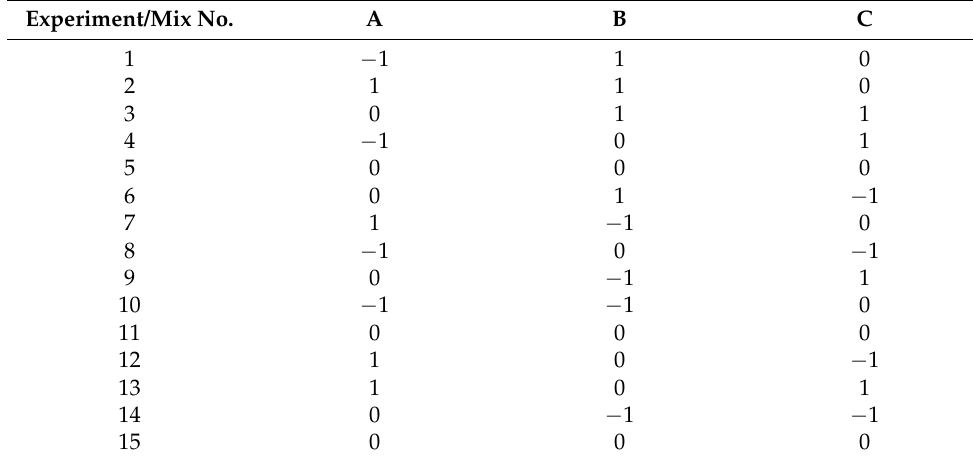
Table 3. Box–Behnken Design for three variables. Experiment/Mix